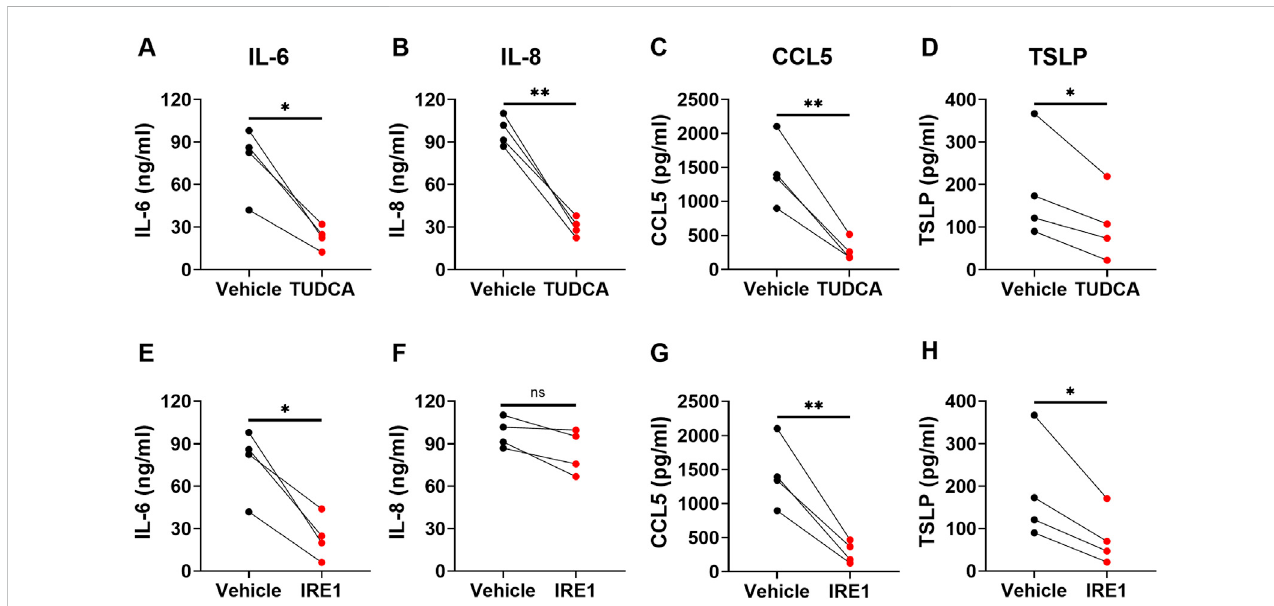
FIGURE 6 The effects of ER stress/UPR pathway inhibitors on cytokine/chemokine secretion by asthmatic lung fi broblasts. Asthmatic fi broblasts were pretreated with TUDCA at 500 μ g/ml (A – D) or IRE1 inhibitor at 25 µM (E – H) for one hour and then cultured with TNF α (20 ng/ml) for 3 days. The levels of cytokines/ chemokinesintheculturesupernatantsweredeterminedbyELISA.Dataareshownasmean±SDfromN=4patientsamples.Eachdotrepresentsonepatient sample. ns: not signi fi cant. * indicates signi fi cant difference p < 0.05. ** indicates signi fi cant difference p <